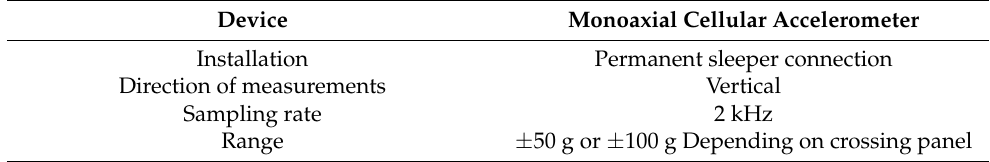
Table 3. Konux GmbH accelerometer properties.